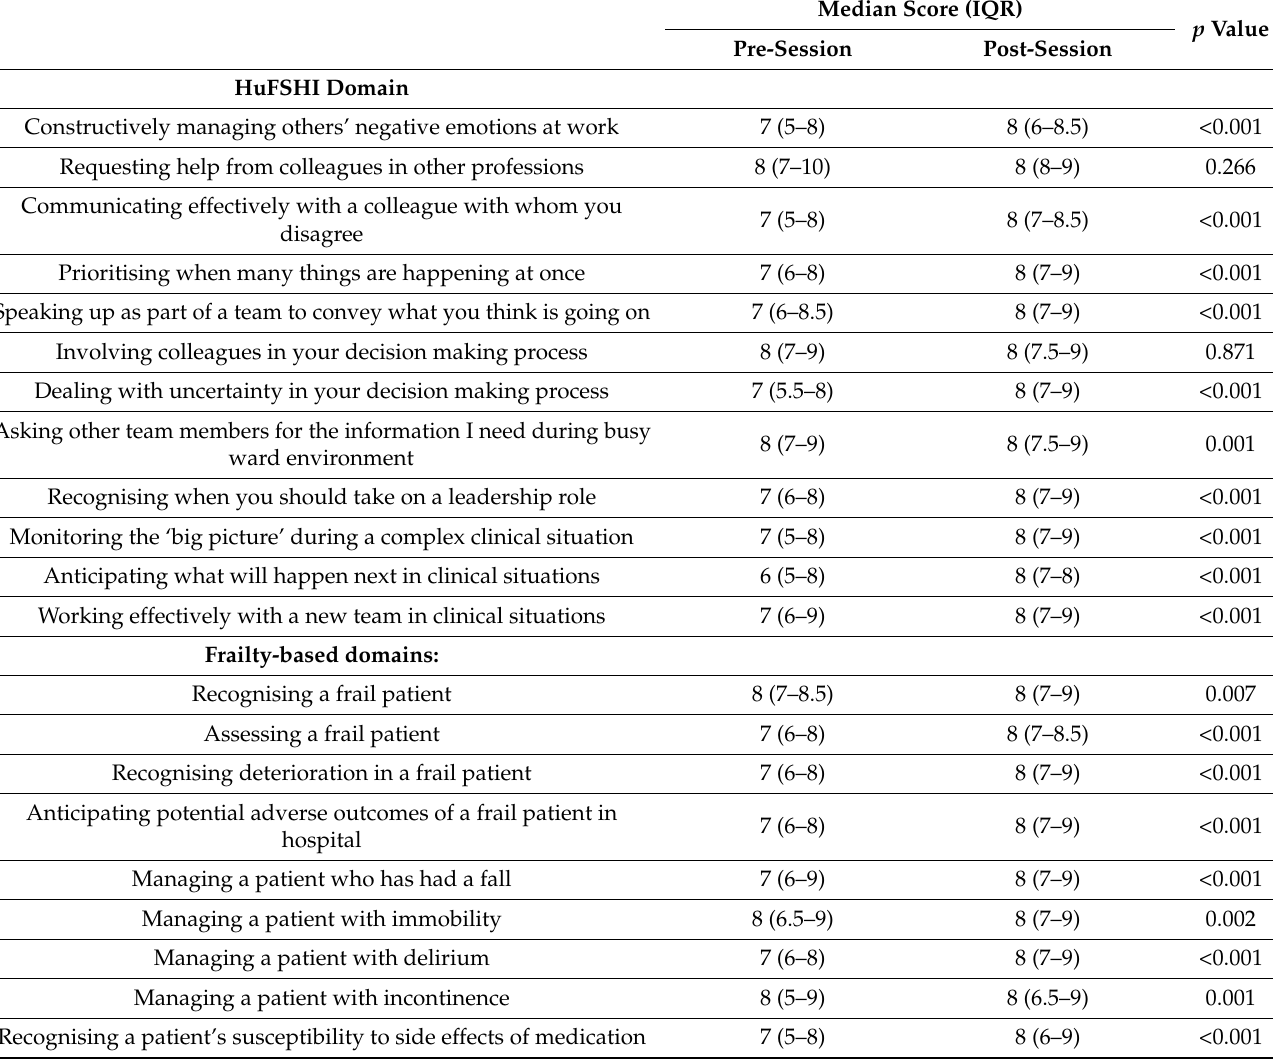
Table 1. Pre- and post-session HuFSHI and frailty domain self-efficacy